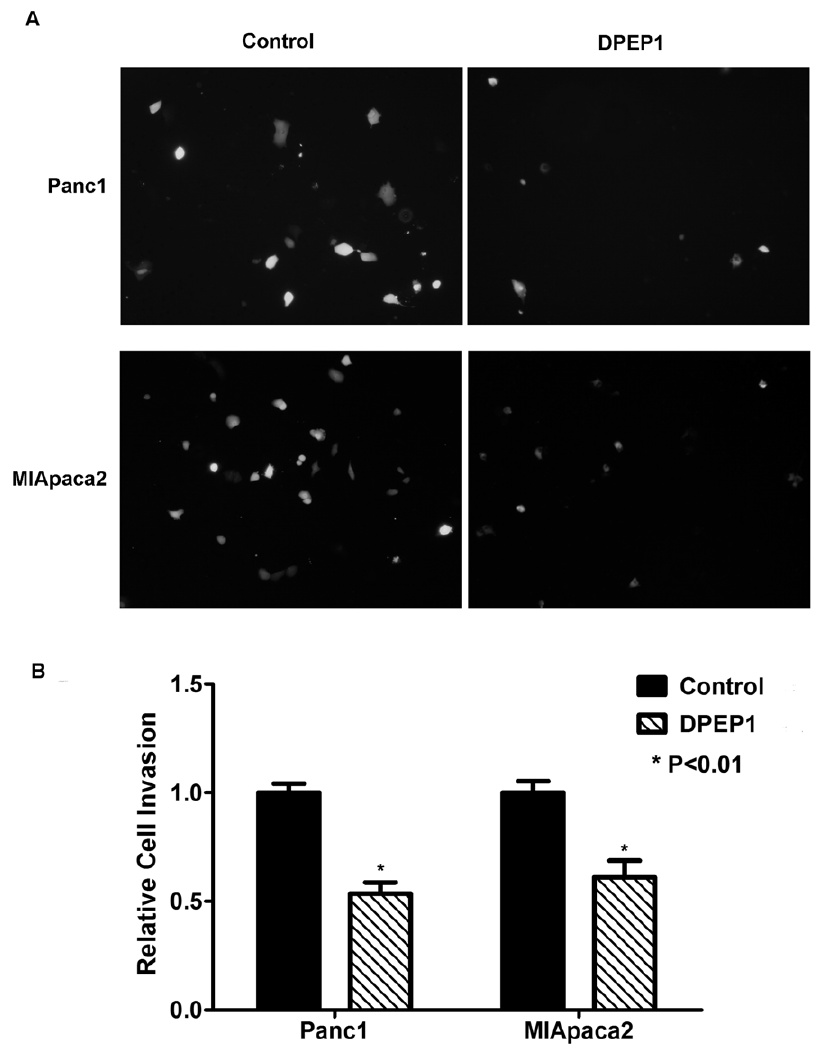
Figure 3. DPEP1 overexpression inhibits cell invasion in Panc1 and MIApaca2 cells. A: Cell invasion was analyzed in Panc1 (upper panel) and MIApaca2 (lower panel) cells using Biocoat matrigel invasion assay. The invaded GFP-positive cells were counted under a fluorescence microscope. B: Relative cell invasion is expressed as the ratio of the percent invasion of a test cell over the percent invasion of a control cell (* P , 0.01).